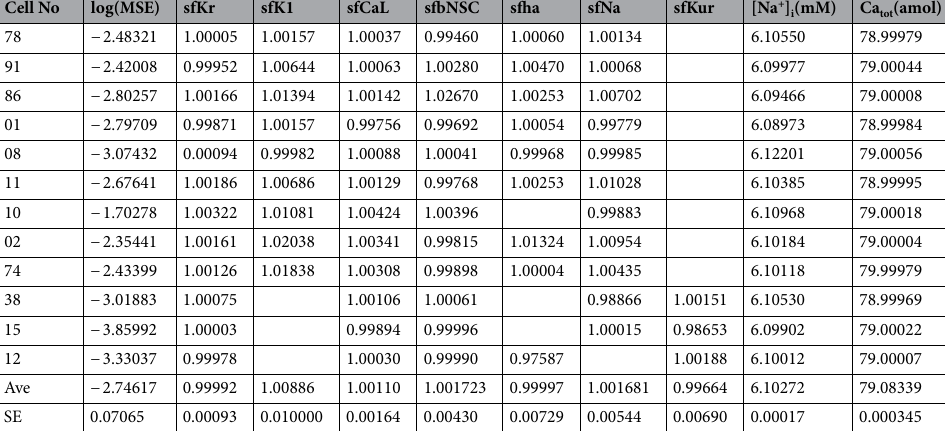
Table 2. Measurements of sf x s (mean + SE, N = 20), [Na + ] i (mM), and Ca tot (amol) in the 12 cells. The top 20 results obtained in the multi-run orp method are analyzed in each cell. Grand average (Ave) and SE are listed in the bottom rows.